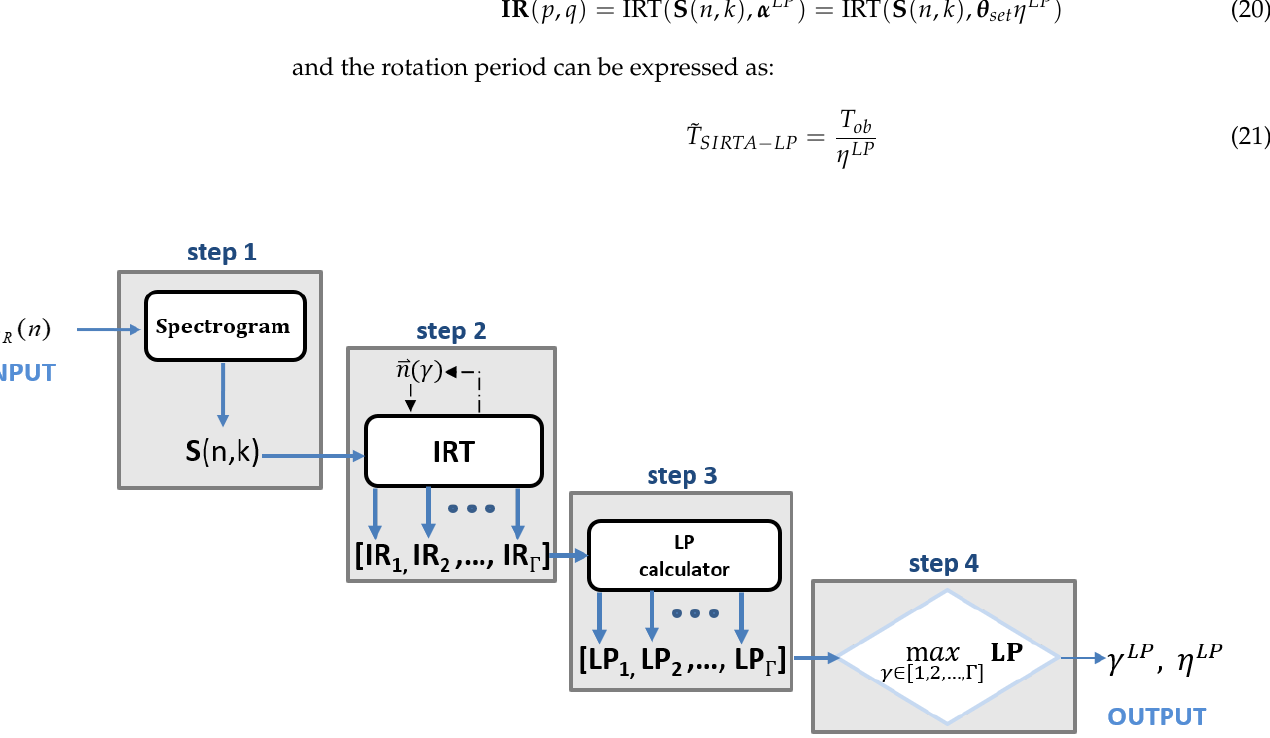
Figure 3. SIRTA-LP algorithm